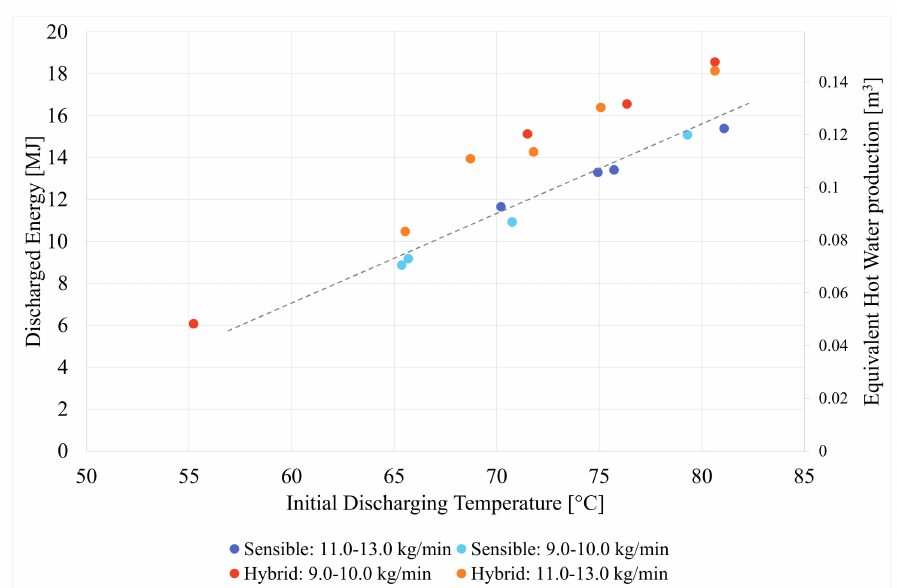
Figure 9. Comparison of the discharged energy storage (left-hand side vertical axis) and equivalent hot water production (right-hand side vertical axis) between sensible and hybrid TES configurations as a function of initial discharging temperature and varying with the heat transfer flow rate.